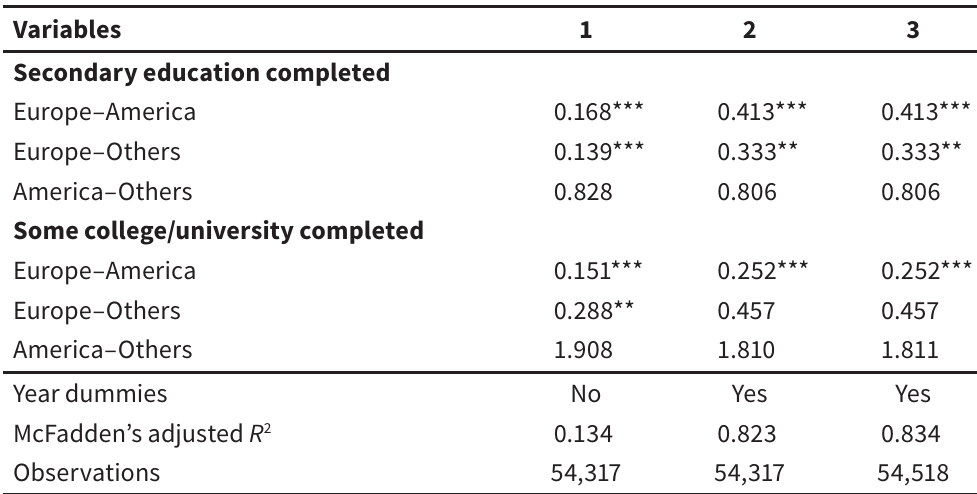
Location choice: destination countries classified by continent (dependent variable: Europe, America, and